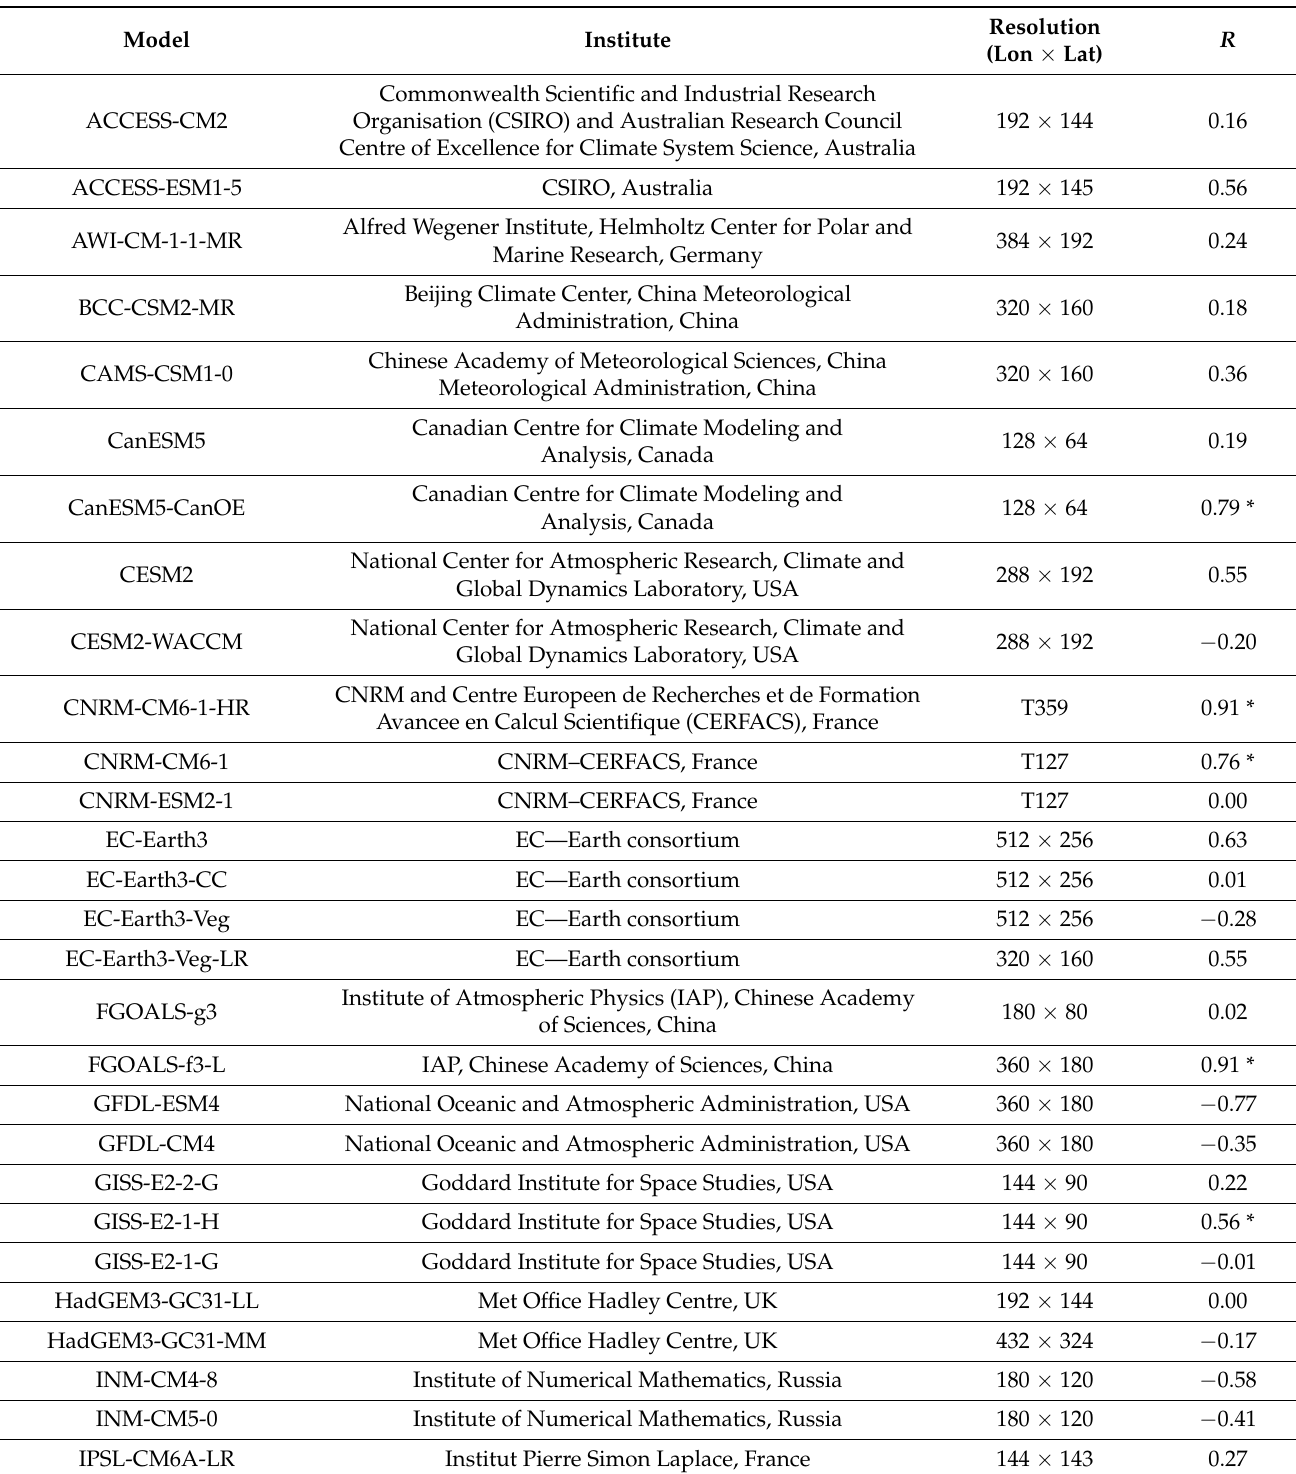
Table 1. Name, institute, and horizontal resolution of the CMIP6 models used in the present study. R denotes correlation between the observed and simulated winter-mean temperature during 1960–2014 in Beijing; * significance at the 95% confidence level according to a two-tailed Student’s t